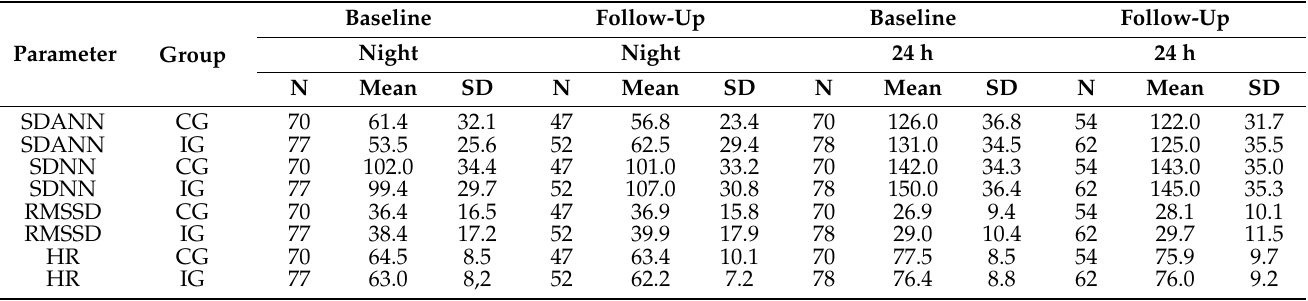
Table 2. HRV parameters at baseline and follow-up.